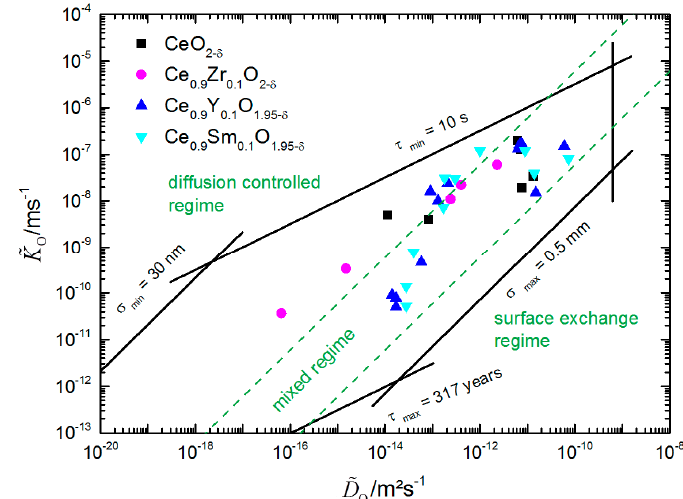
Figure 7. The accessible K - D window plotted partially together with K - D -Data derived in non-equi- librium experimental conditions in the temperature range T = 300 °C to T = 800 °C utilizing C 18 O 2 . Additionally, the boundaries for the kinetic regime are drawn [30,35].